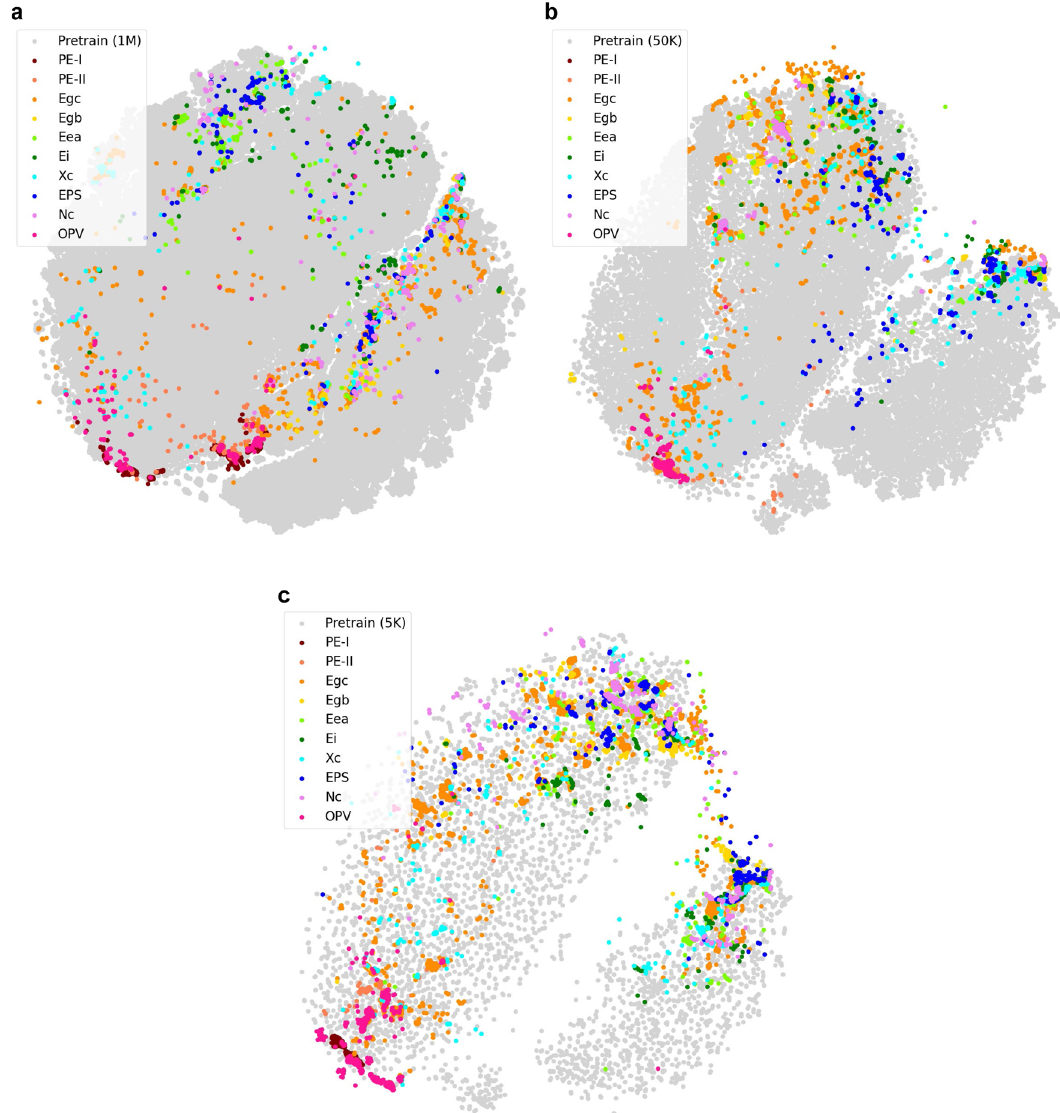
Fig. 3 t-SNE visualization of pretraining and downstream data. The embeddings are obtained by fi rst fi tting on the ( a ) 1M (original), ( b ) 50K, and ( c ) 5K pretraining data and then transforming downstream data to the corresponding data